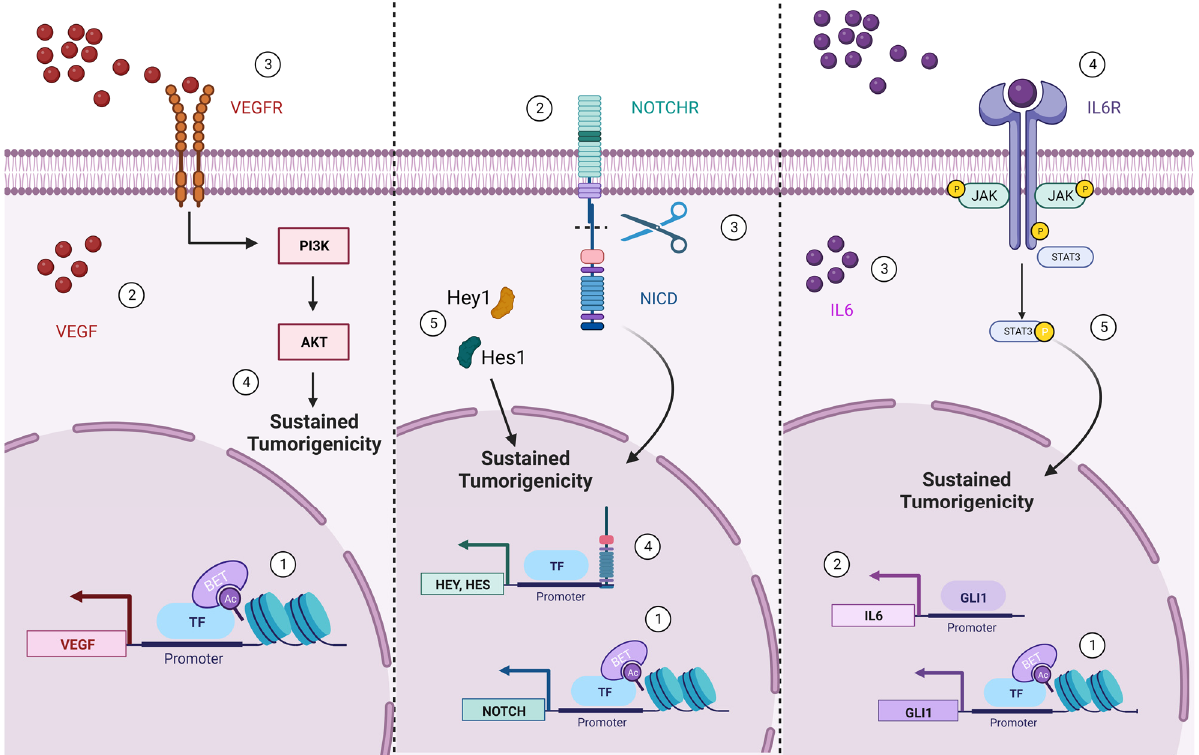
Figure 3. Oncogenic pathways regulated by BET proteins in GBM. BET proteins positively regulate some oncogenes involved in the main GBM dysregulated signaling pathways promoting survival, death evasion and stemness maintenance. The numbers in the caption indicate the temporal sequence of the events.